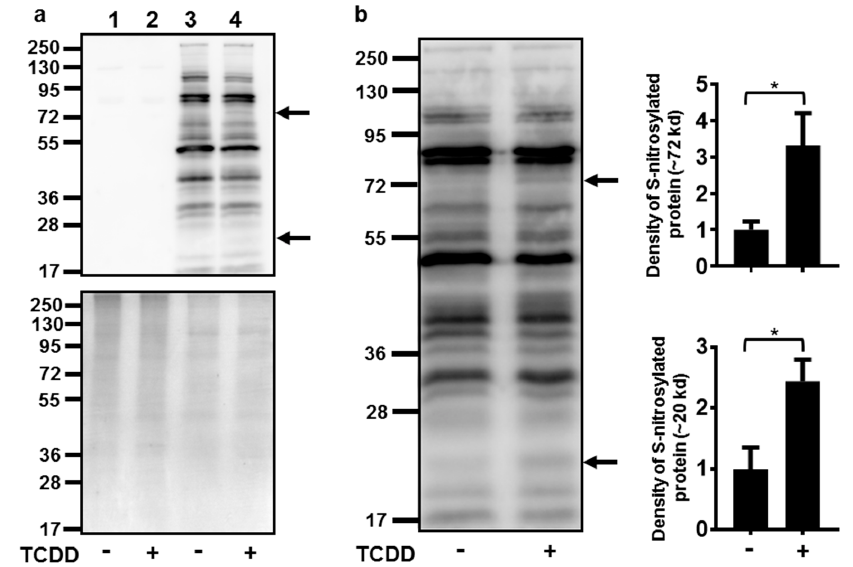
Figure 4. Activation of the AHR increased the S -nitrosylation of a 72 and a 20 kD protein. ( a ) Controls for S -nitrosylation biotin switch assay. Upper panel immunoblot of samples without performing the switch assay (lanes 1 and 2) to determine the assay background and with performing the switch assay (lanes 3 and 4). Treatment with TCDD (72 h, 10 nM) is as indicated. The arrows to the right of the immunoblot images indicate the proteins with increased S -nitrosylation. Numbers to the left correspond to molecular weight markers in kilodaltons. The upper band corresponds to a protein ~72 kD and the lower arrow, a protein ~20 kD. Lower panel, the same samples as in the upper panel were run in parallel and stained with coumassie blue to demonstrate similar protein loading of samples. ( b ) Quantitation of protein S -nitrosylation. Left, immunoblot of S -nitrosylated proteins. Treatment with TCDD is as indicated. The numbers to the left correspond to molecular weight markers in kilodaltons. The upper arrow corresponds to a protein ~72 kD and the lower arrow corresponds to a protein ~20 kD. Right, levels of protein S -nitrosylation of ~72 kD and ~20 kD proteins (mean ( n = 4) +/- SD) were quantified by densitometry, and plotted relative to DMSO, set to a value of one. * indicates a significant difference, p < 0.05. Data were analyzed using two-tailed Student’s t -test. 3. Discussion Metabolic regulation of cell fate is described for several biological systems including macrophages [20], stem cells [21], vascular endothelial cells [22], and T cells [23]. Our recent studies [10] demonstrate that AHR-mediated keratinocyte differentiation occurs through a series of metabolic reprogramming events including a decrease in glycolysis by the down-regulation of the glucose transporter, SLC2A1, and the glycolytic enzyme, ENO1. The decrease in glycolytic flux stimulates an increase in SIRT1 that is reversed by pyruvate supplementation. Furthermore, AHR- mediated keratinocyte differentiation is dependent on this increase in SIRT1. Down-regulation of glycolysis using glycolysis pathway inhibitors has the similar effect as activation of the AHR on keratinocyte differentiation, demonstrating that a decrease in glucose metabolism is sufficient to affect keratinocyte cell fate. In addition to glycolysis, activation of the AHR affects mitochondrial oxidative phosphorylation causing ATP levels and inner mitochondrial membrane potential to decrease. Concomitantly, the ratio of GSH/GSSG decreases, consistent with lower levels of glutathione reductase activity, and mitochondrial ROS levels increase. Importantly, inhibition of ROS with antioxidants decreases the AHR-mediated acceleration of differentiation [7]. Consistently, epidermal deletion of the murine mitochondrial transcription factor A (TFAM) diminishes mitochondrial ROS and inhibits epidermal differentiation [24]. Due to the significant contribution of